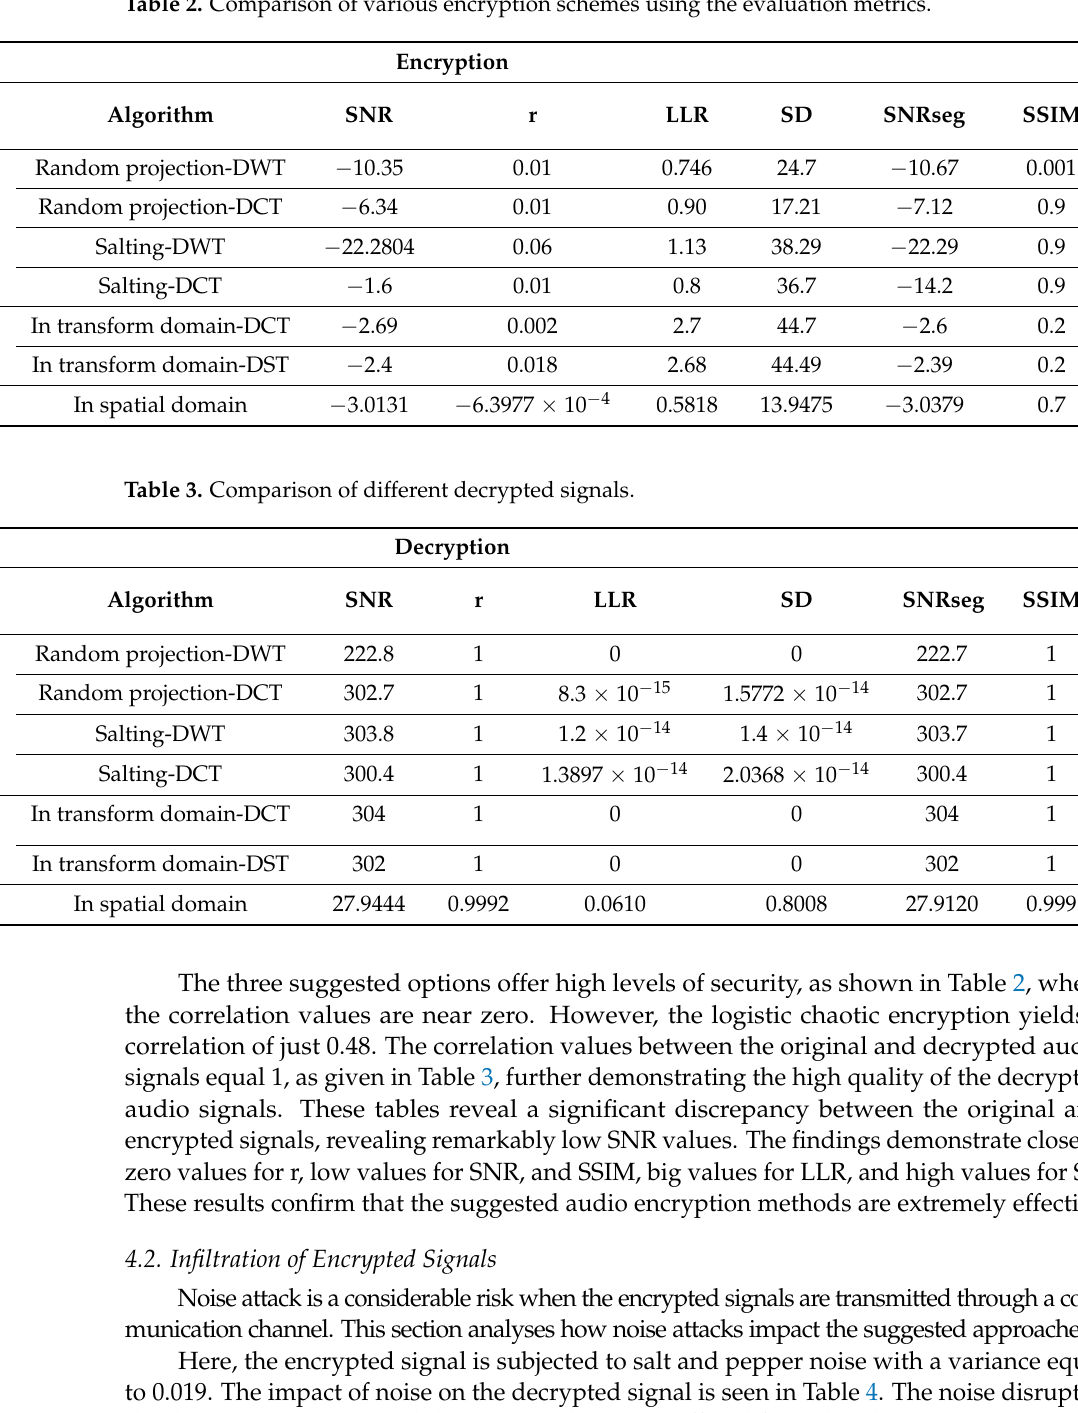
Table 2. Comparison of various encryption schemes using the evaluation metrics.